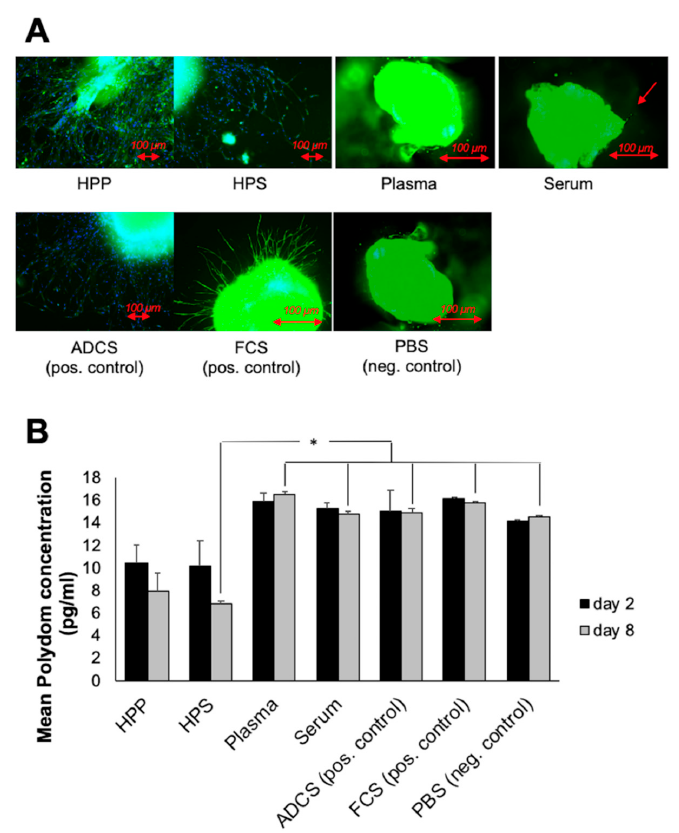
Figure 4. Validation of the lymphatic sprouting assay. ( A ) Panel showing representative images of immunohistochemical staining of thoracic duct rings with Anti-LYVE-1 (anti-lymphatic vessel endothelial hyaluronan receptor-1) (colored green) and DAPI (colored blue) in lymphatic sprouting assays (8 days), carried out in the presence of blood-derived secretomes (hypoxia preconditioned plasma (HPP) and serum (HPS), normal plasma and serum), as well as positive controls (adipose-derived cell suspension(ADCS) and fetal calf serum (FCS)) and negative control (phosphate buffered saline (PBS)) samples (Bars = 100 µm). ( B ) Quantitative analysis of polydom in thoracic duct ring assays. Plot showing the polydom concentration (pg/ml), measured in culture supernatants obtained following medium change in thoracic duct ring assays at 2 and 8 days. (* p < 0.05). Error bars represent s.d. ( n = 3).